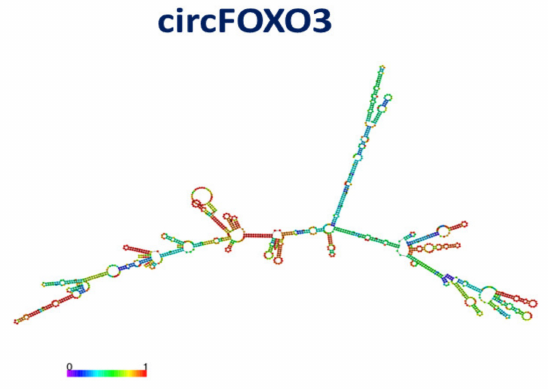
Figure 11. Drawing of the best model for the secondary structure of circFOXO3; colors of the spots indicate the corresponding pair-base probability (see the scale at the